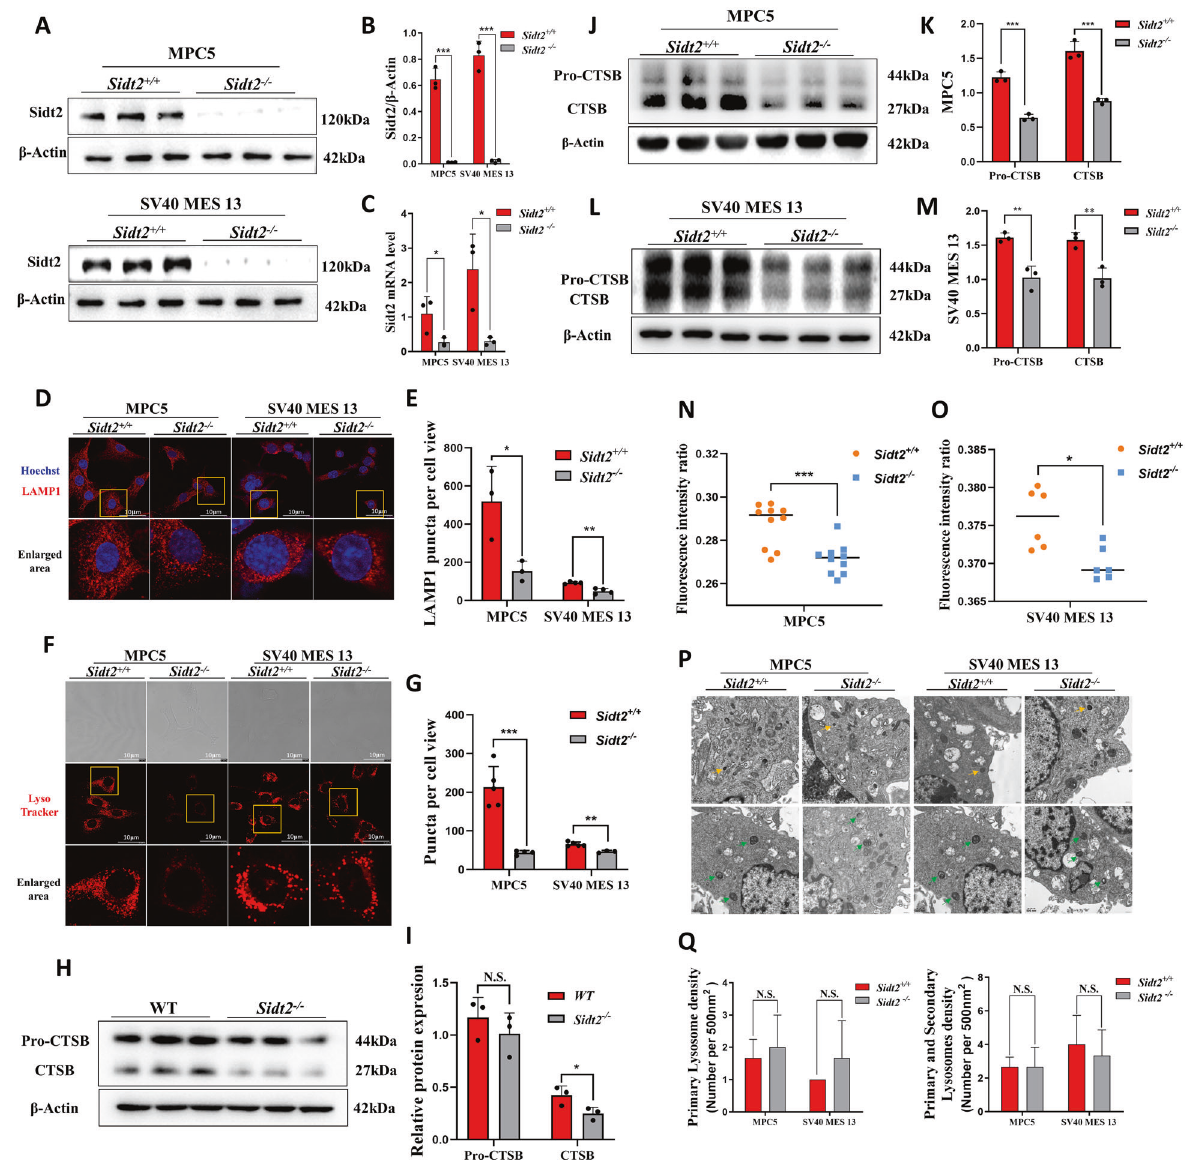
Fig. 2 Effect of Sidt2 deletion on the total number of lysosomes, the number of acid lysosomes, and the lysosomal environment and acid hydrolase. A Sidt2 protein expression level determination by western blot; B statistical charts of the western blot test results; C Sidt2 mRNA expression level determination by qRT-PCR; D LAMP1 immuno fl uorescence in MPC5 and SV40 MES 13 cells before and after Sidt2 knockout; E statistical chart of ( D ); F LysoTracker determination of the number of functional lysosomes before and after Sidt2 knockout in MPC5 and SV40 MES 13 cells; G statistical graph of the LysoTracker results; H Cathepsin B expression in WT and Sidt2 − / − mice kidney; I statistical chart of ( H ); J Cathepsin B expression in MPC5 cells before and after Sidt2 knockout; K statistical chart of ( J ); L Cathepsin B expression in SV40 MES 13 cells before and after Sidt2 knockout; M statistical chart of ( L ); N LysoSensor detection of the lysosomal pH change on Sidt2 knockout in MPC5 cells; O LysoSensor detection of the lysosomal pH change on Sidt2 knockout in SV40 MES 13 cells; P electron microscopy application to observe the change in the number of lysosomes in kidney cells on Sidt2 knockout (yellow arrows mark primary lysosomes and green arrows mark secondary lysosomes); Q statistical chart of the ( P ). * P < 0.05, ** P < 0.01, *** P < 0.001. spots increased (Fig. 5B) and the Pearson correlation coef fi cient lysosomes to form autophagolysosomes and the degradation of between LC3B and LAMP1 decreased (Fig. 5C), suggesting autophagolysosomes. In order to further explore the reasons for the decreased co-localization. In order to exclude the possibility that failure of autophagy clearance after Sidt2 deletion, we fi rst studied the decrease in the co-localization with LC3B was caused by a the fusion process of autophagosomes and lysosomes. The red fl uorescence used to mark LC3B can represent autophagosomes, decrease in the number of LAMP1 fl uorescence points after the Sidt2 deletion, we further standardized the fusion rate of and LAMP1 labeled with green fl uorescence as the lysosome autophagosomes and lysosomes. We calculated the ratio of the marker. At the basic autophagy level, we investigated the number of fl uorescent spots co-localized with LAMP1 and LC3B to immuno fl uorescence colocalization of LC3B and LAMP1 after Sidt2 the number of fl uorescent spots of LAMP1 in the two groups of deletion in MPC5 and SV40 MES 13 cells (Fig. 5A). The results cells after the Sidt2 deletion. The results showed that the fusion rate showed that after Sidt2 deletion, the number of LC3B fl uorescence Cell Death and Disease (2022)